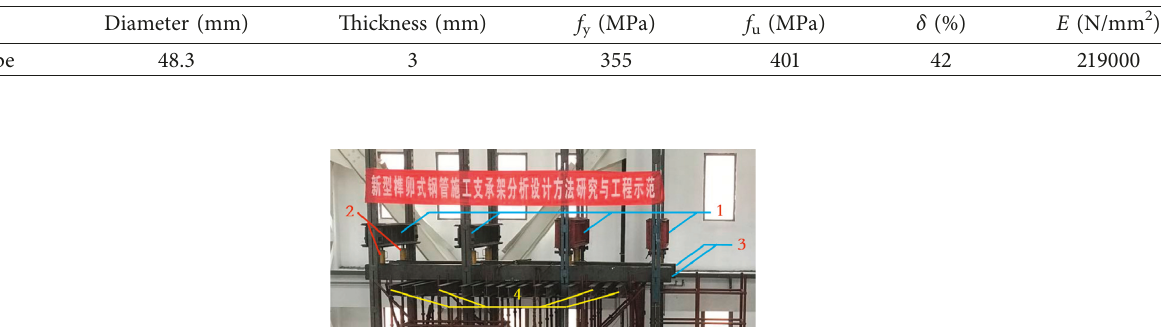
Table 2: Test data of material properties.